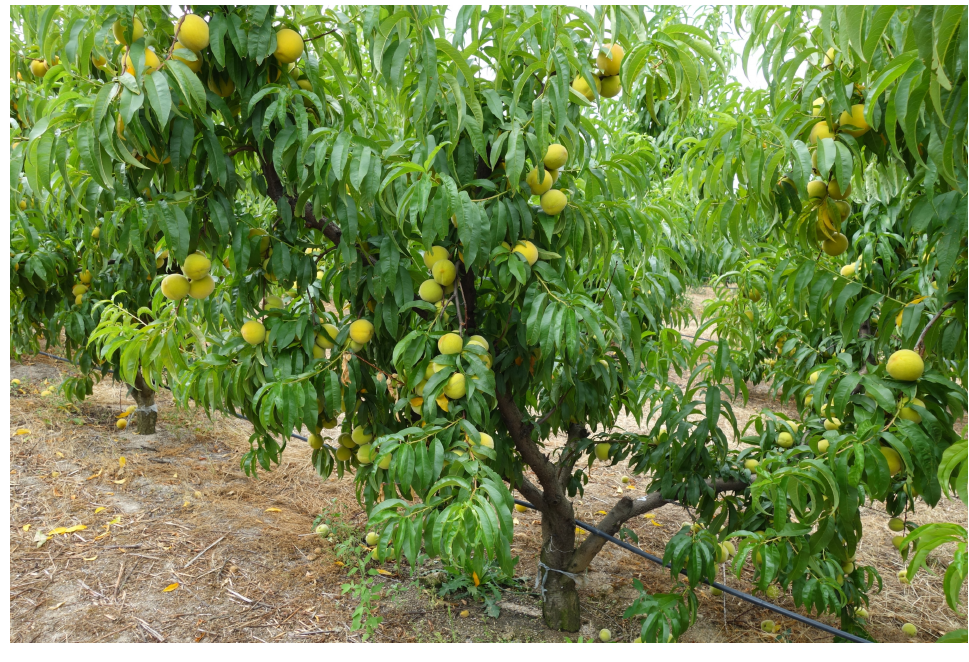
Figure 2. Training sample image.